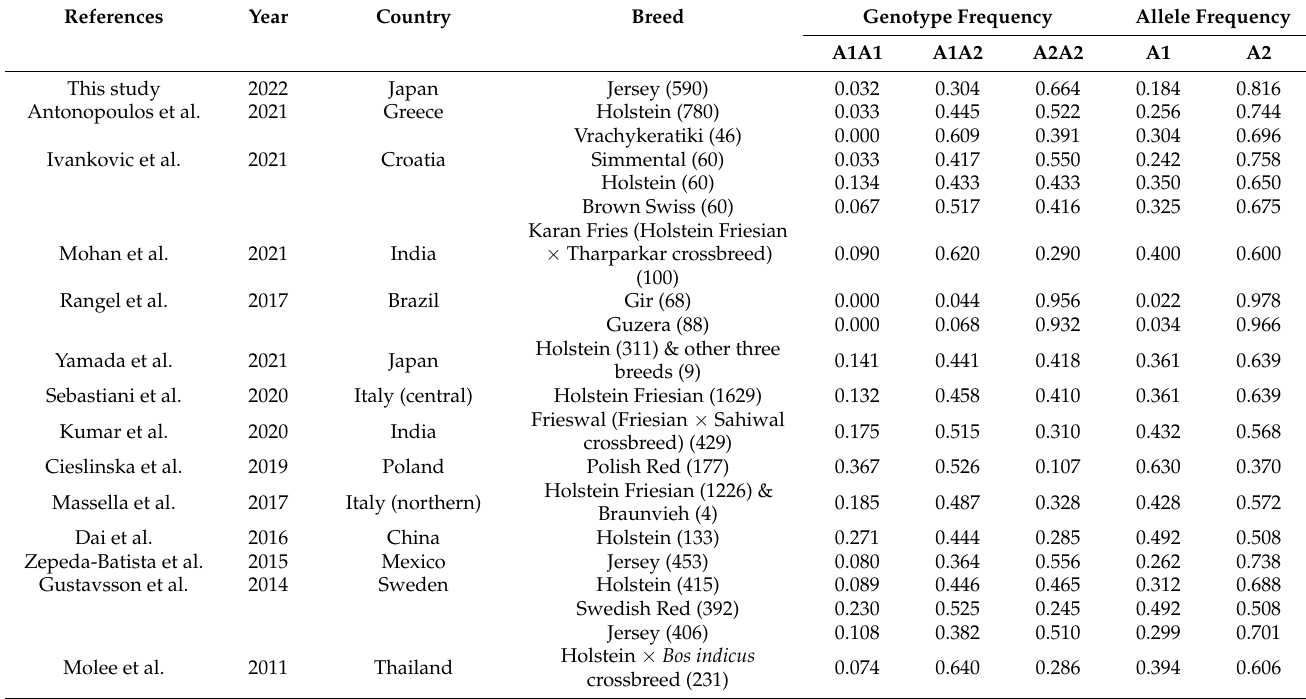
Table 4. Comparison between reported studies of genotype and allele frequencies of β -casein genes in Holstein, Jersey, and other